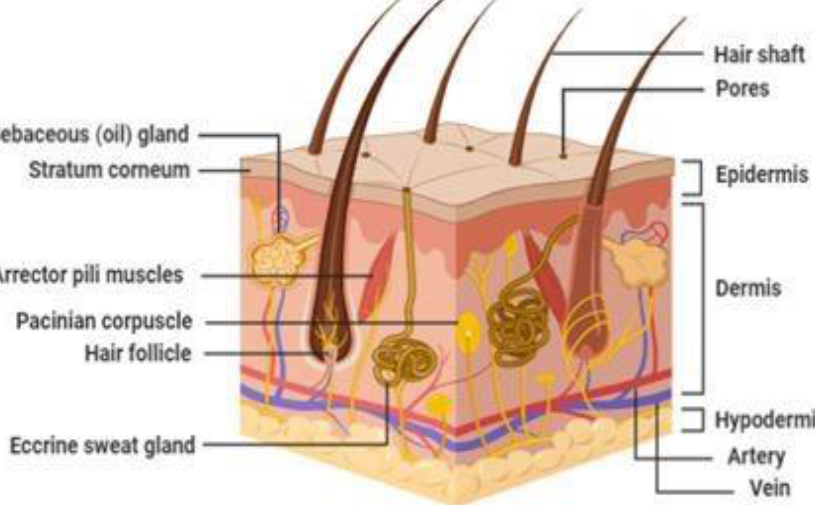
Figure 1. Microscopic structure of the